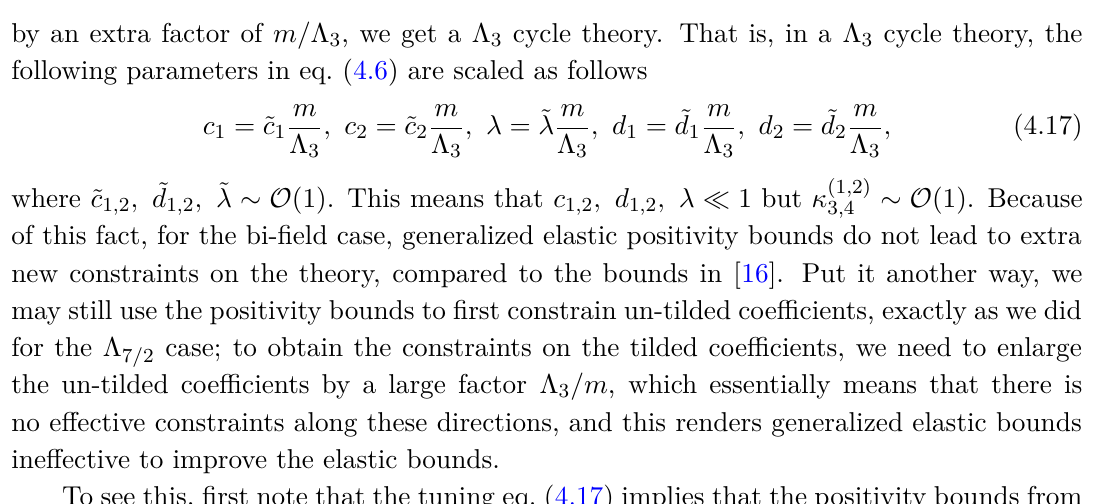
symmetric case. The black 2 , κ , and λ 3 4